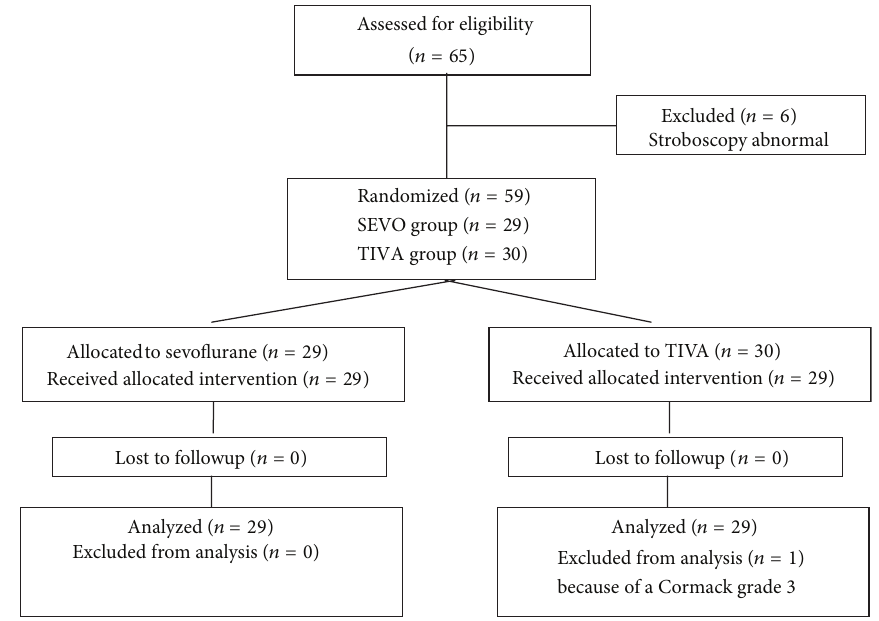
Figure 1: Flow diagram of patient distribution. Sevoflurane = anesthesia with sevoflurane and remifentanil. TIVA = anesthesia with propofol and remifentanil.